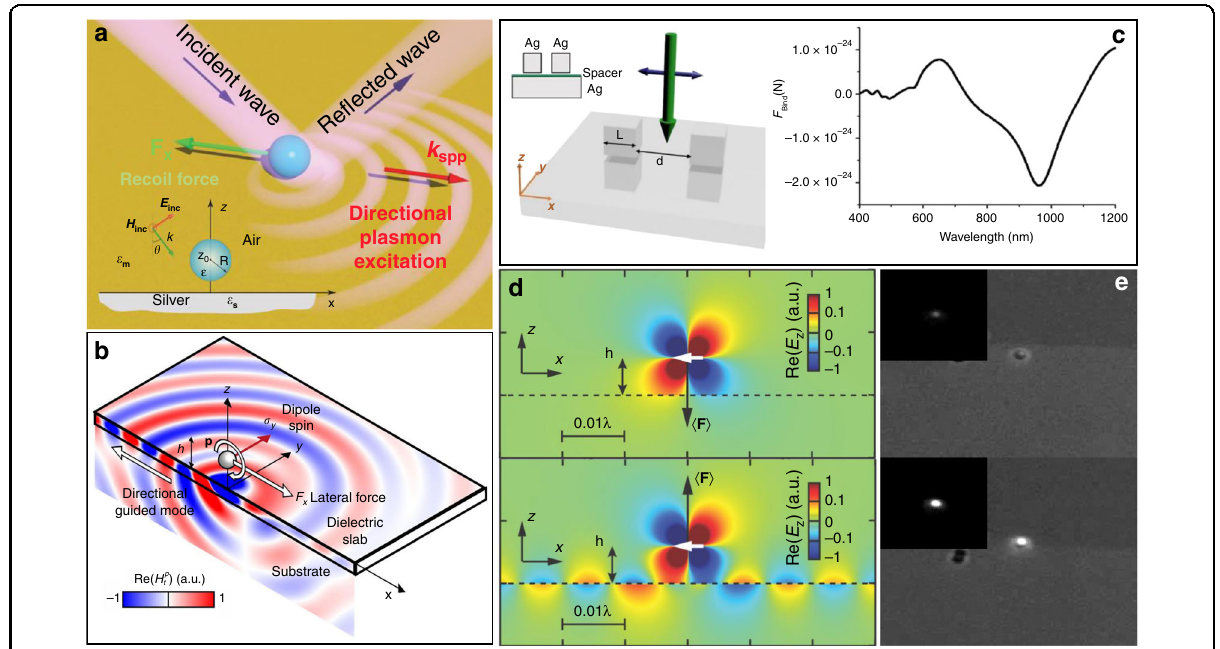
Fig. 12 Unconventional plasmonic forces and manipulations. a Recoil force created by surface plasmon polaritons on a particle, directed opposite to the propagation direction of incident light. The inset shows the geometry of the system. b Lateral force exerted on a dipole near a surface. The dipole handedness, direction of the guided mode excitation in a slab, and lateral force are indicated by coloured arrows. c Schematic of two plasmonic cubes over a plasmonic substrate and reversal of the binding force. d Nonzero chemical potential of the graphene-assisted plasmonic repulsion effect (upper), with the lower fi gure as a comparison at zero potential. e Femtosecond-pulsed plasmonic nanotweezers-enhanced fl uorescence in the absence of a nonlinear response from bowtie nanoantenna arrays; insets are fl uorescence results without illumination. a Adapted with permission from ref. 64 , Copyright 2015, WILEY-VCH Verlag GmbH & Co. KGaA, Weinheim. b Adapted with permission from ref. 66 ,